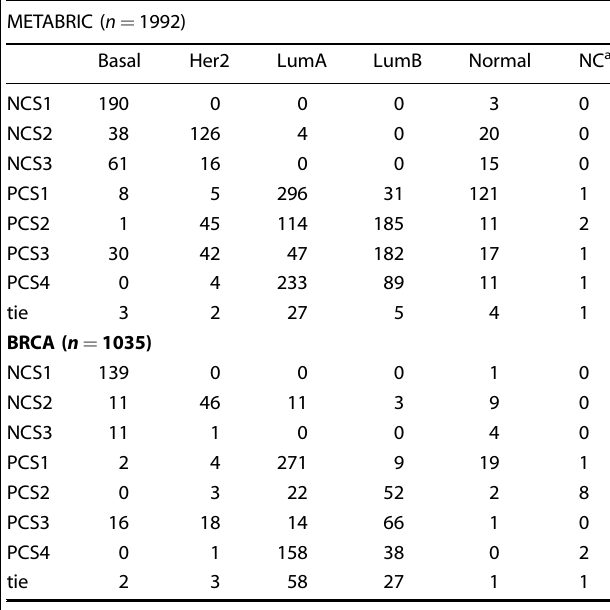
Table 1. Distribution of samples classi fi ed by both BCCS and PAM50 subtypes for METABRIC and BRCA cohorts. METABRIC ( n = 1992)